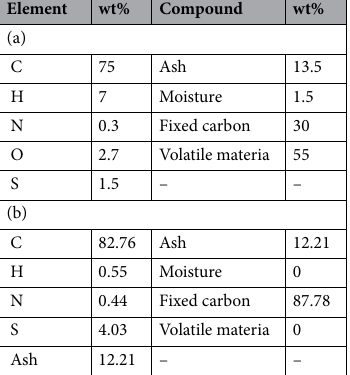
Table 2. ( a ) Ultanal and Proxanal assessment of the tire, ( b ) Proxanal and Ultanal assessment of the char.